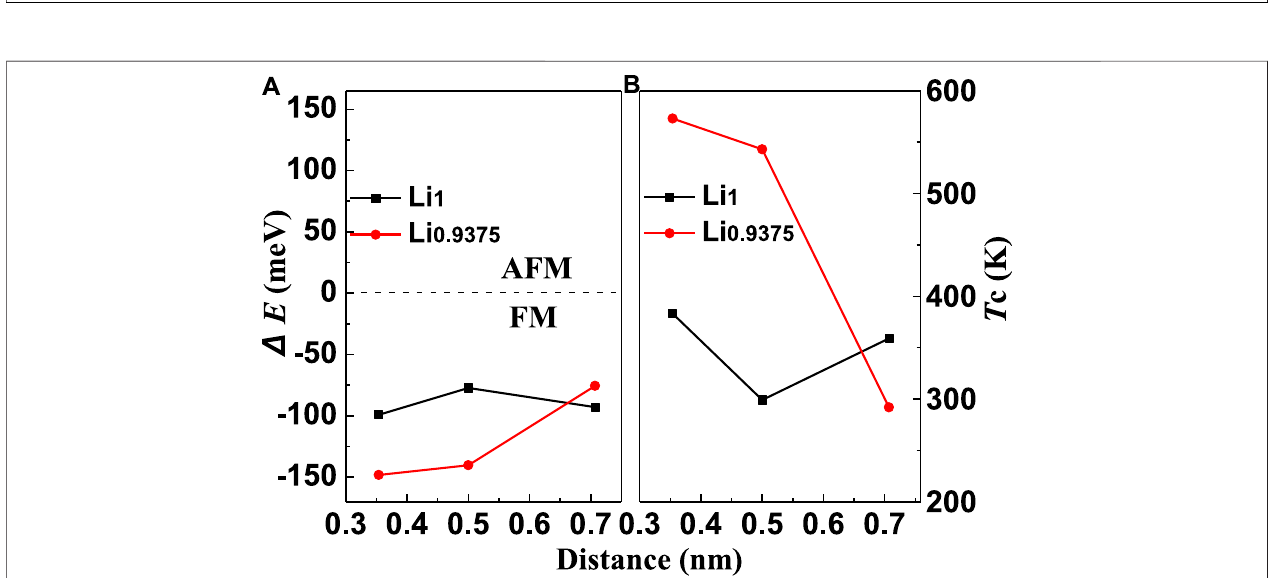
FIGURE 5 | The energy difference of the ferromagnetic and antiferromagnetic state (A) and the Curie temperature (B) as a function of the two doped Cu atoms distance for Li 1-y (Mg 0.875 Cu 0.125